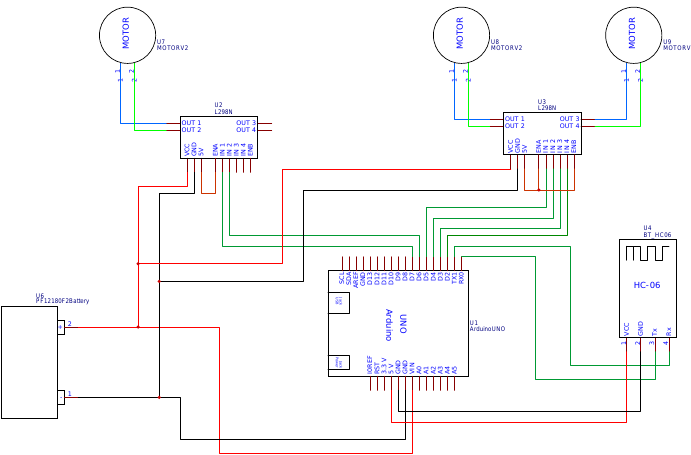
Figure 7. Advanced console connection schematic.